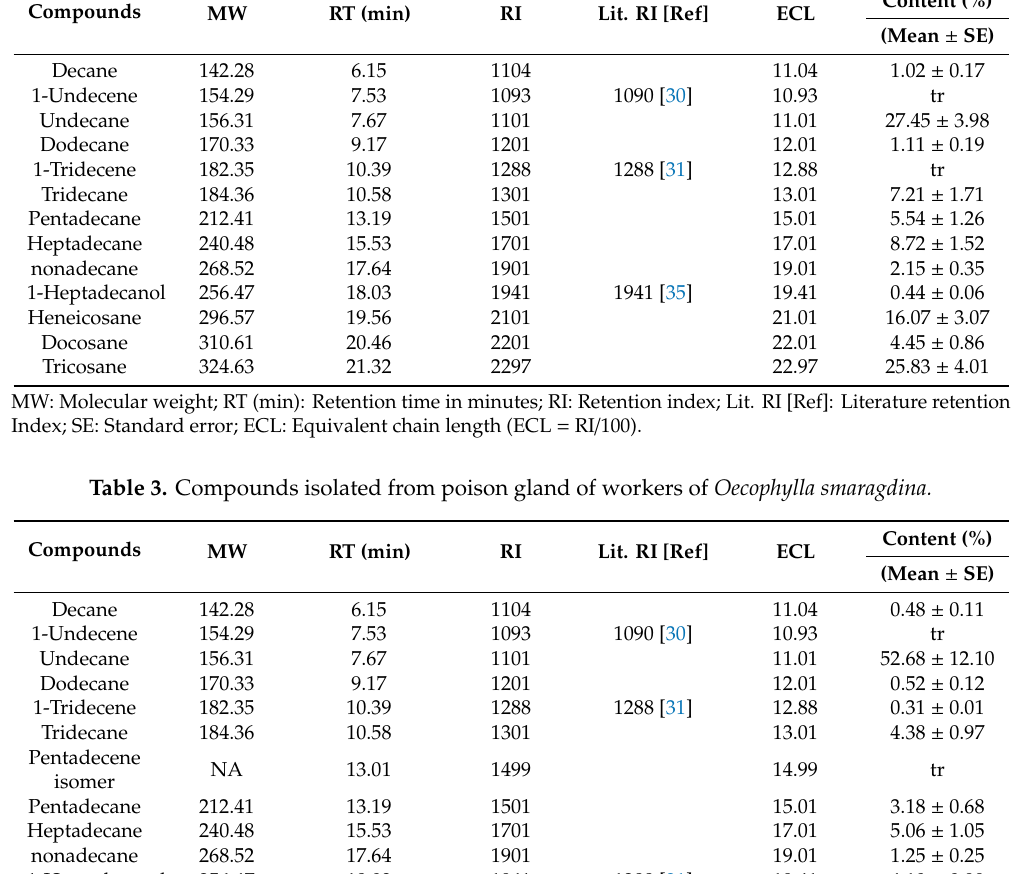
Table 2. Compounds isolated from Dufour’s gland of workers of Oecophylla smaragdina. Compounds